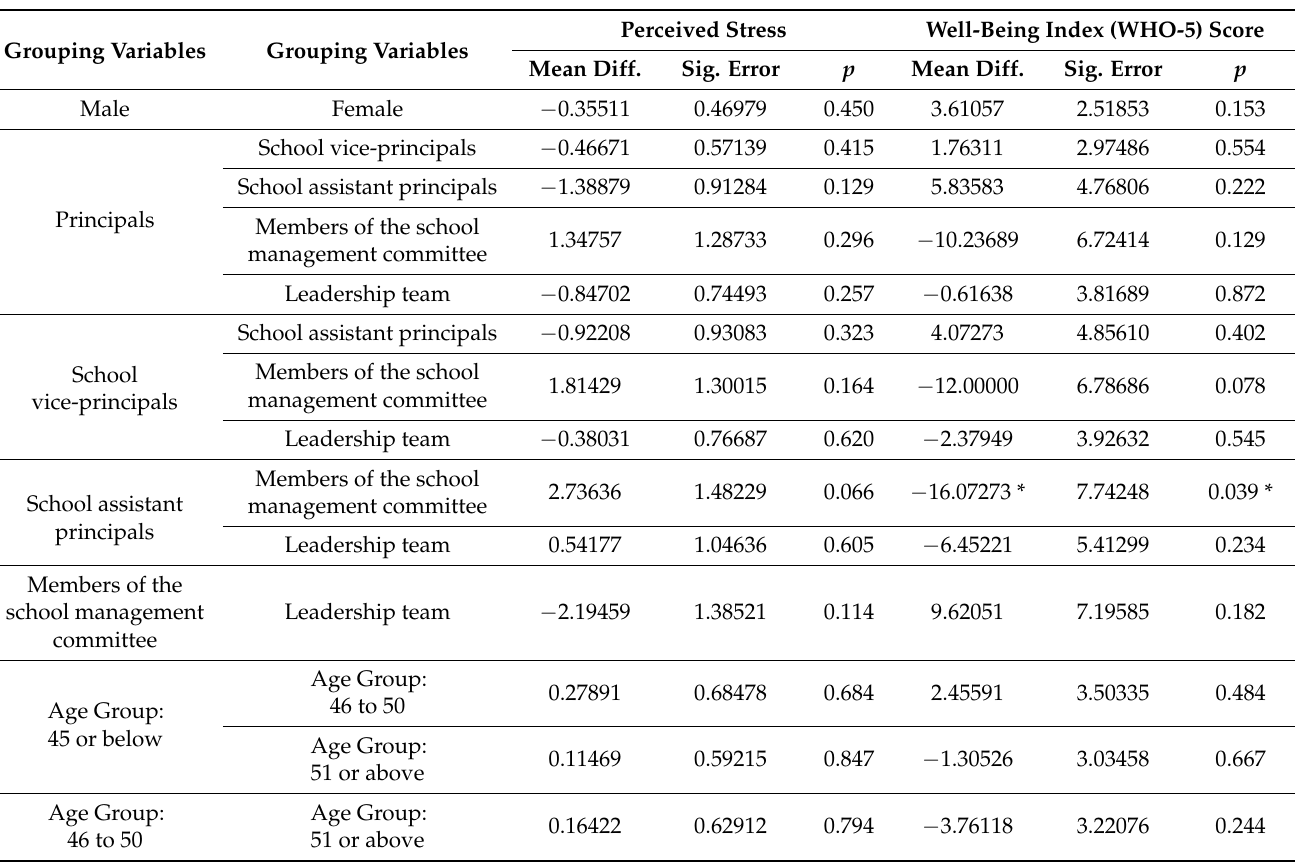
Table 4. Results of independent-samples Student’s t-tests and least significant difference post hoc